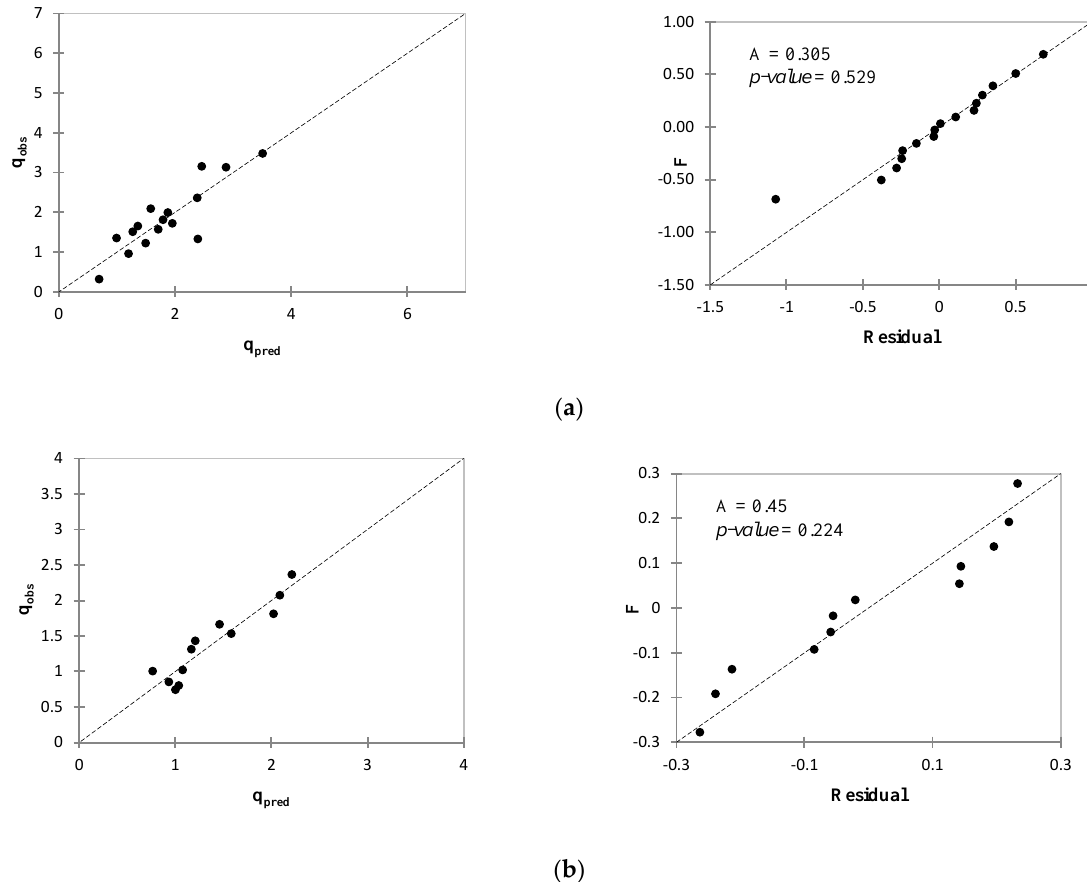
Figure 6. Differences between observed and calculated q 95 (dm 3 ∙s − 1 ∙km − 2 ) for ( a ) cluster 3_2 and ( b ) cluster 3_3.